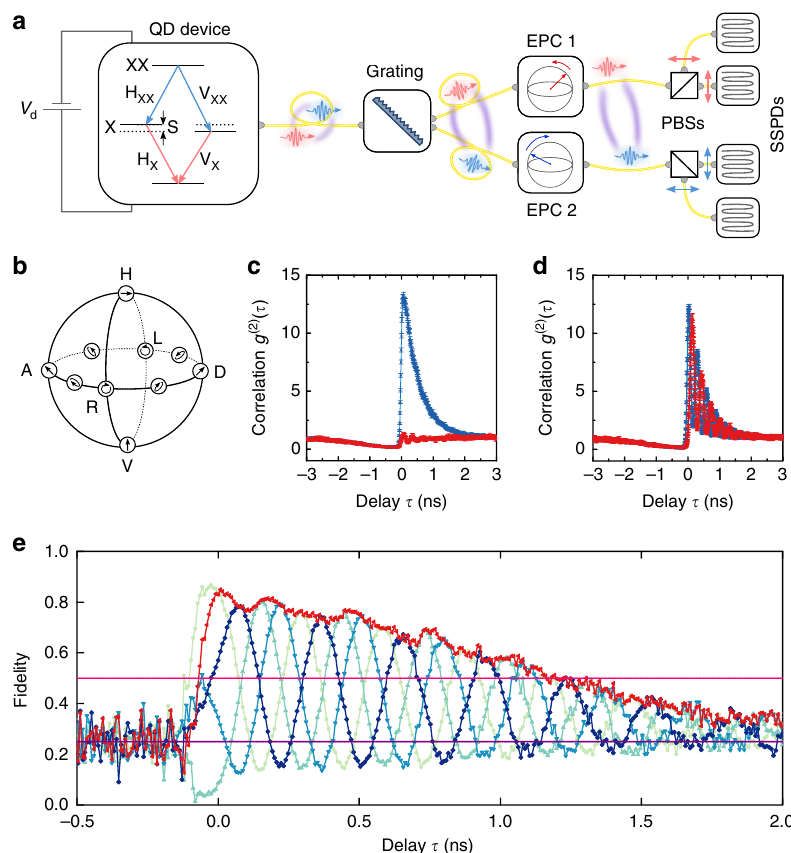
Fig. 2 Measurement of entanglement fi delity. a Schematic drawing of the entanglement setup. The entangled photons are generated by the biexciton cascade shown diagrammatically in the fi rst panel. X and XX photons are separated by a diffraction grating and sent to their respective polarisation sensitive detection units. These consist of electronic polarisation controllers (EPCs) and polarising beam splitters (PBSs) to prepare the detection system in one of fi ve measurement bases. Polarisation selected photons are measured using superconducting single photon detectors (SSPDs). b Schematic of the Poincaré sphere, with measured bases indicated by cartoons of the photon polarisation. c , d Co-polarised (blue curves) and cross-polarised (red curves) biexciton – exciton photon coincidences measured in the HV and DA bases, respectively. e Entanglement fi delity to four maximally entangled states with phases χ = 0, π /2, π and 3 π /2 (light to dark blue curves), as well as to an evolving state (red curve). Pink and purple lines give the classical limit and uncorrelated values for coincidences,